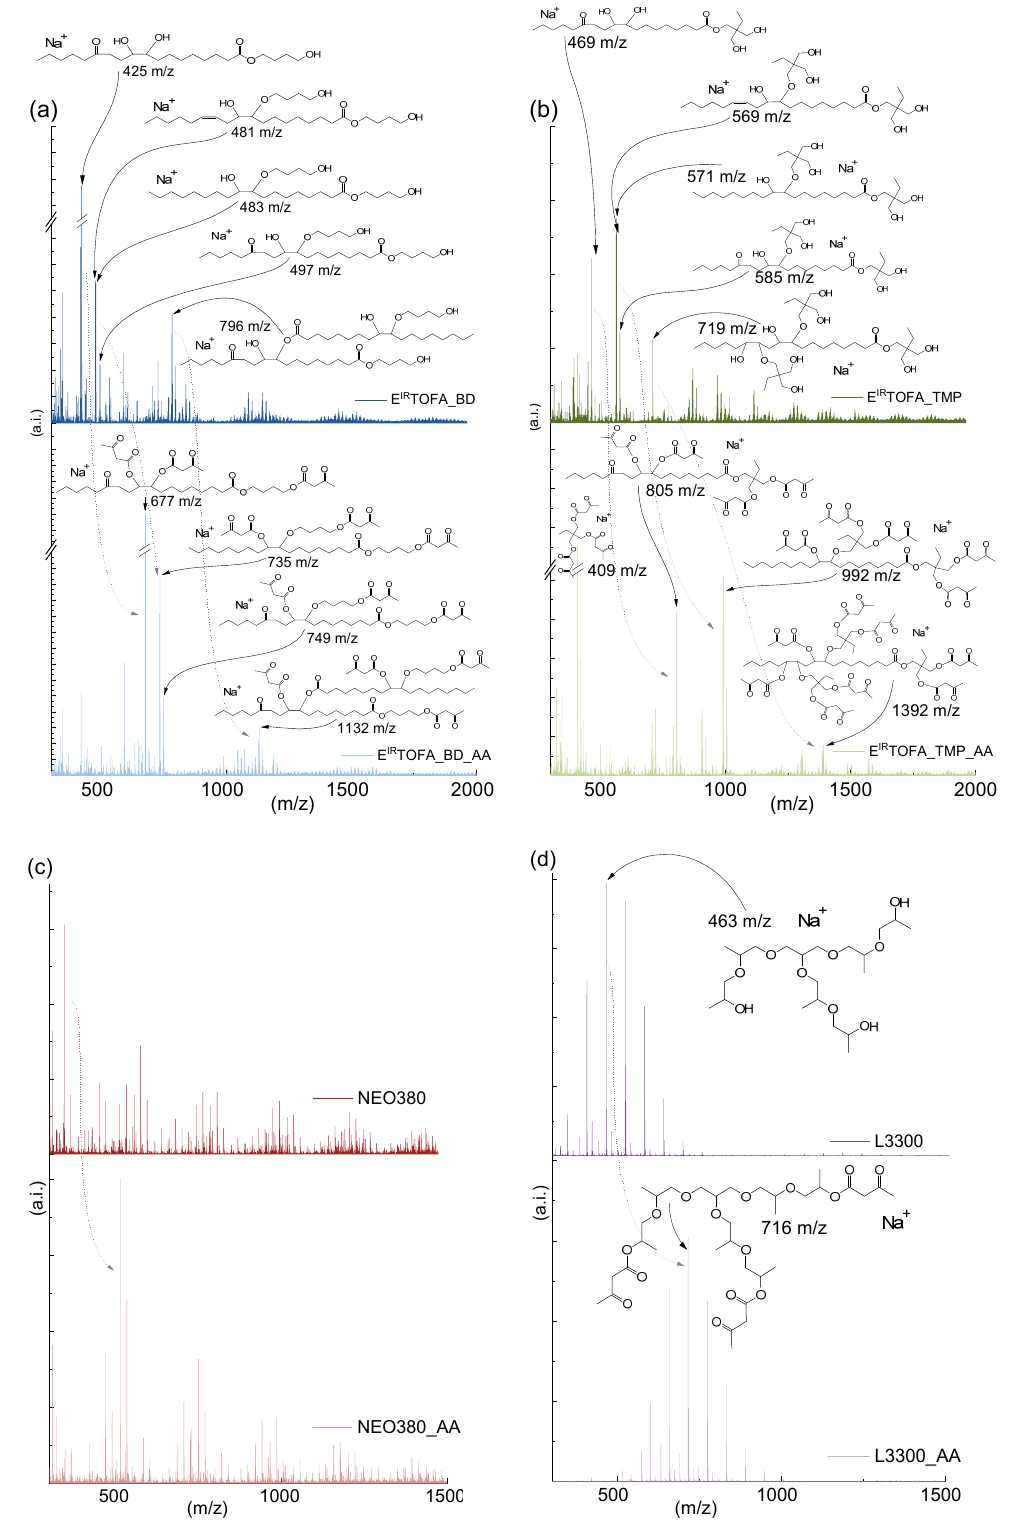
Figure 4. MALDI-TOF spectra of synthesized polyols and acetoacetylated polyols: ( a ) spectra of E IR TOFA_BD and E IR TOFA_BD_AA; ( b ) spectra of E IR TOFA_TMP and E IR TOFA_TMP_AA; ( c ) spectra of NEO380 and NEO380_AA; ( d ) spectra of L3300 and L3300_AA. For more information, see Supplementary Materials Table S1.